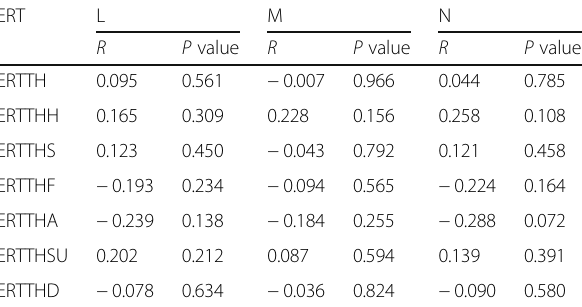
Table 4 Correlation between subtypes of ADHD according Conner ’ s parent rating scale- revised (L) and items of ERT (total hits and total hits of each emotion separately) ERT L M N R P value